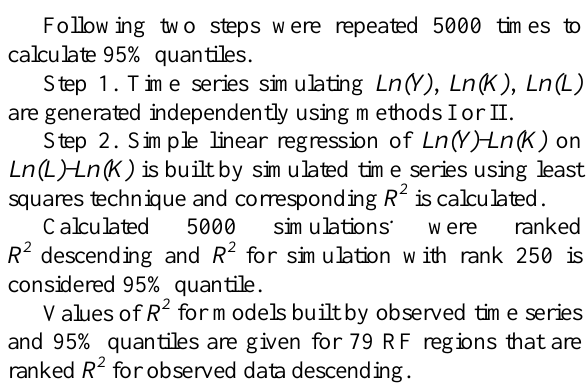
Fig. 1. Result for short models of type